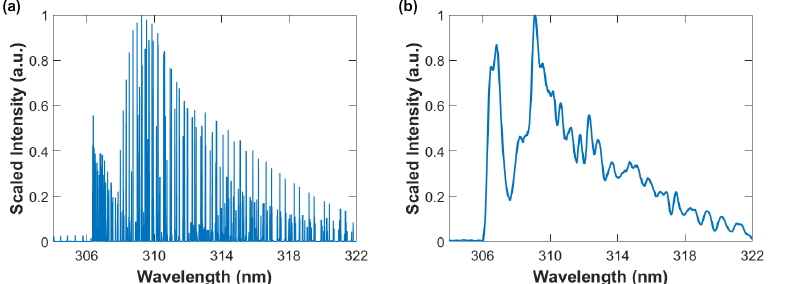
Figure 3. Computed spectra: T = 4000 K; Spectral resolution ( a ) 0.001nm and ( b ) 0.35nm.